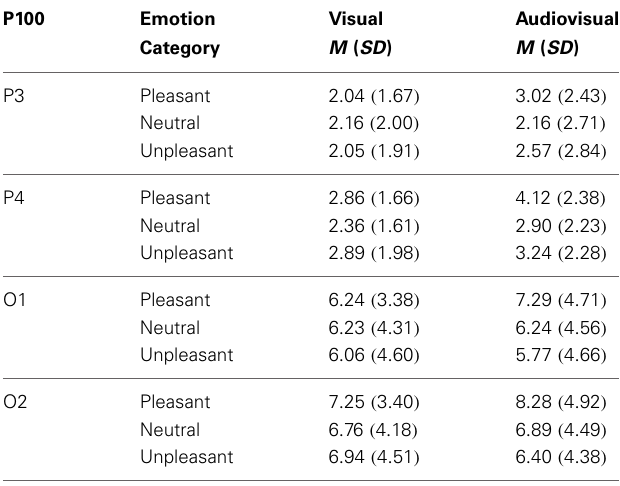
Table 2 | Mean and standard deviation for the P100 amplitude on parietal (P3,P4) and occipital electrodes (O1,O2) in response to visual and congruent audiovisual